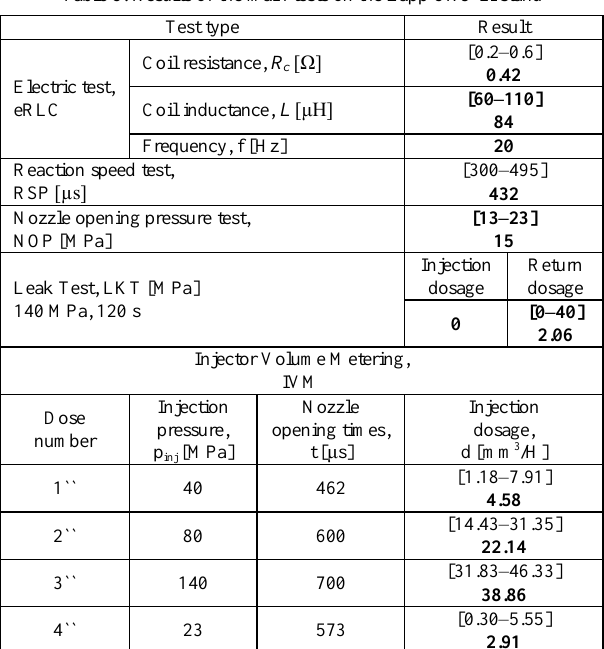
Table 5. Results of the main tests on the Zapp CRU 2i stand